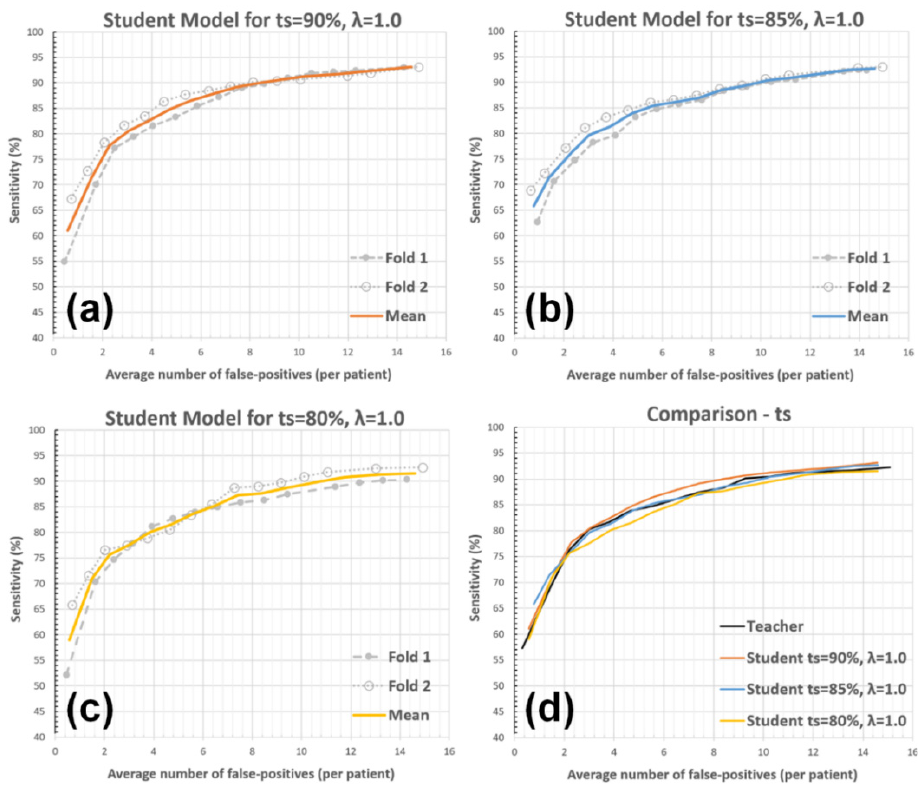
Figure 7. The impact of response threshold ( 𝜇 ) on the AFP metric. The student model performances for ( a ) ts = 90%—(default setup), ( b ) ts = 85%, ( c ) ts = 80%, and ( d ) comparisons between the teacher and student models with these setups are presented.